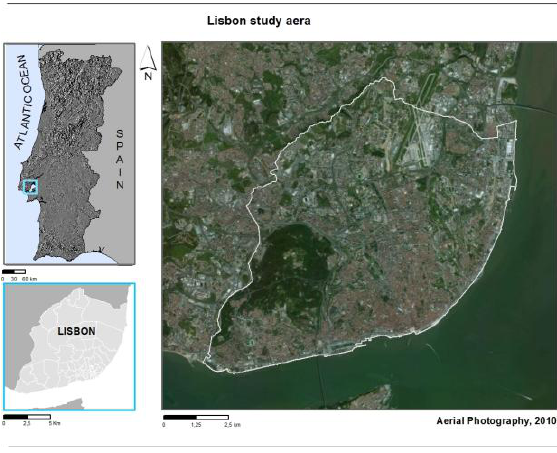
Figure 1. Study area for deriving Urban Indicators in Lisbon